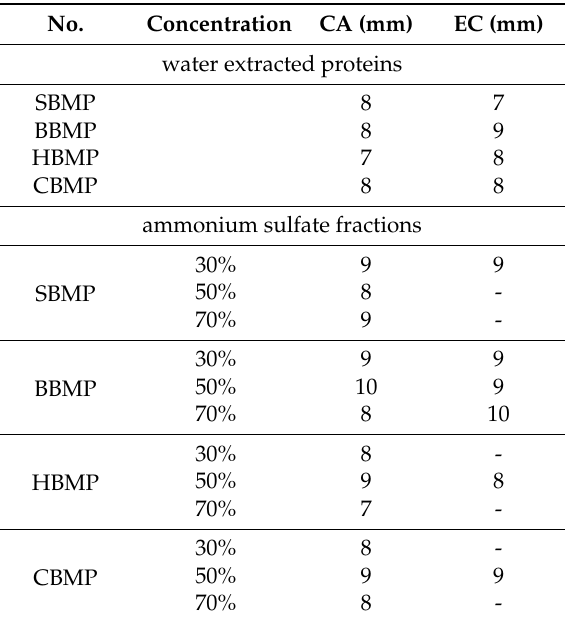
Table 3. Comparison of antimicrobial activity from different